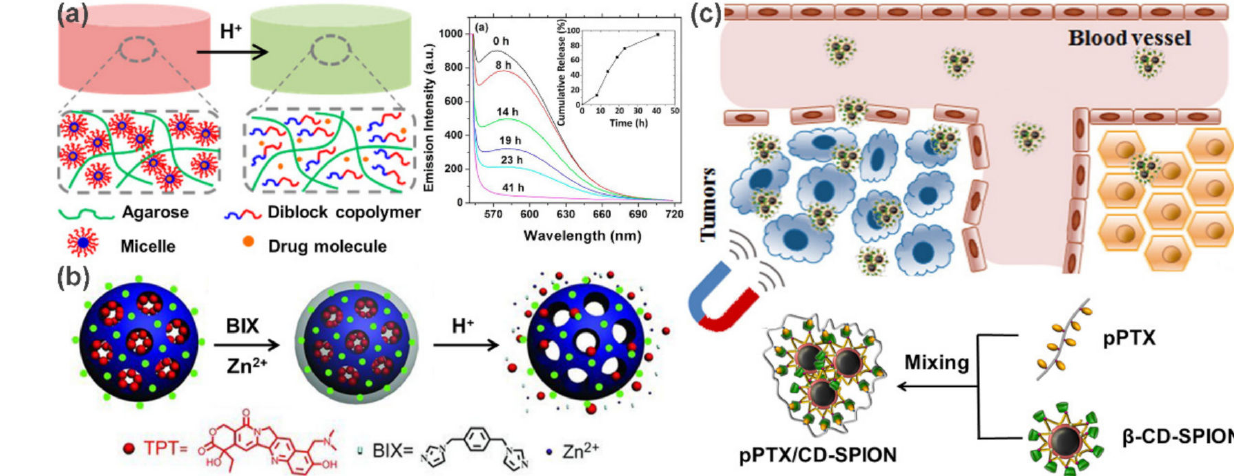
Figure 4. Controlled drug delivery systems for cancer theranostics. ( a ) Agarose hydrogels embedded with pH-responsive micelles for pH-triggered drug release. ( b ) Schematic illustration of the preparation and pH-responsive release of coordina- tion polymer coated MSNs. ( c ) Schematic illustration of the fabrication of pPTX/CD-SPION nano-assemblies and their application in magnetically guided drug delivery. Adapted with permission from Refs.